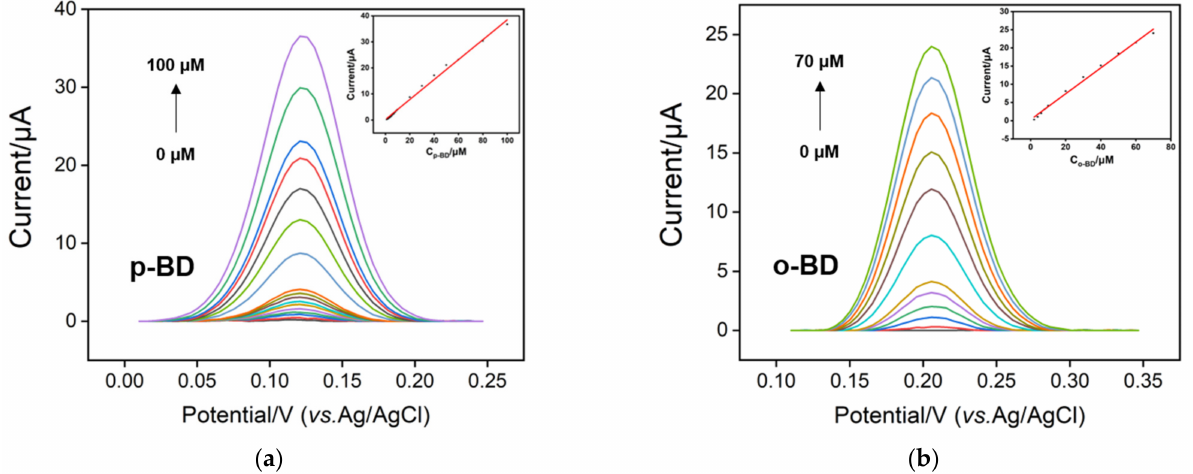
Figure 6. DPV responses of p-3DG electrode to various concentrations of p-BD ( a ) or o-BD ( b ) in 0.1 M PBS (pH 7). The insets show the corresponding calibration curves. Error bars denote the standard deviations of three